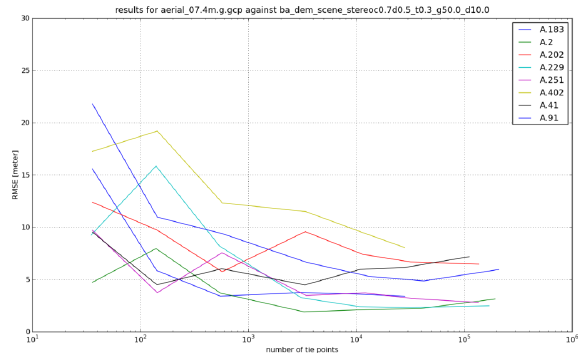
Figure 5: Evaluation of lateral accuracy vs number of LSM tie points. Each line corresponds to a scene overlapping with test area 7.